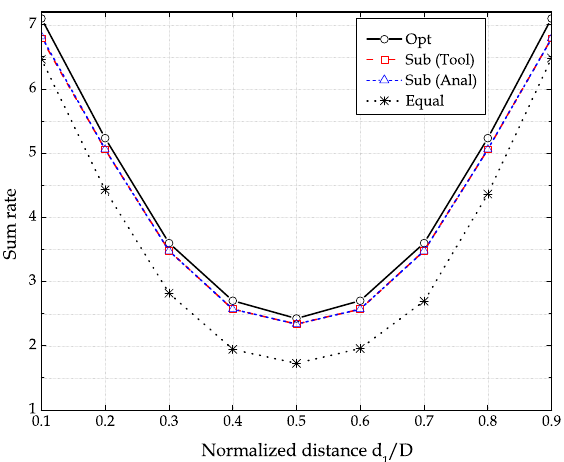
Figure 4. Sum rate of the PS-SWIPT with different resource allocation methods as a function of d 1 / D when P = 20 dBm and ν = 3.